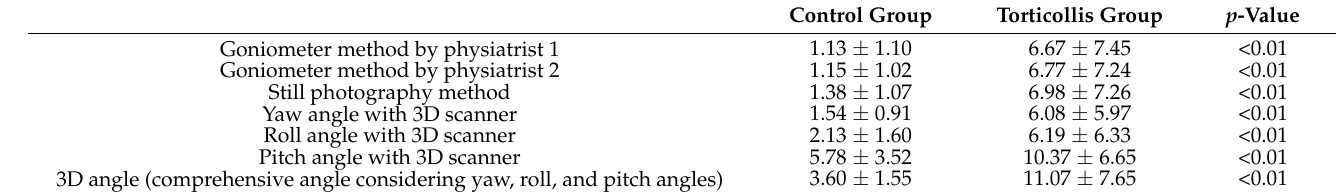
Table 1. Angles with multiple methods and difference in angles between the control and torticollis groups.